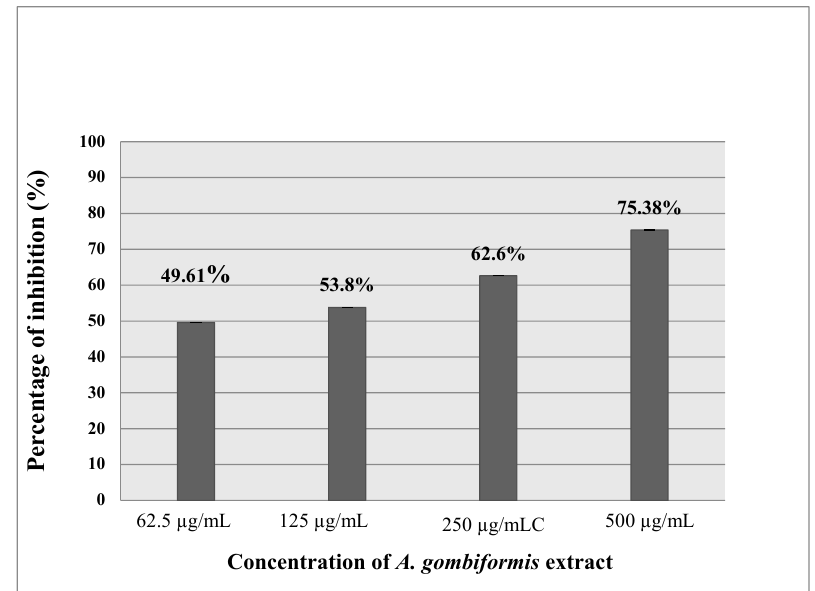
Figure 4. In vitro anti-inflammatory effect of A. gombiformis extract. Table 3. In vitro anti-inflammatory effect of A. gombiformis extract and reference compounds.EC50 values are expressed as means ± SD of three replicates. The same subscript letters are not signifi- cantly different following the Tukey’s honestly significant difference post hoc test at p < 0.05.